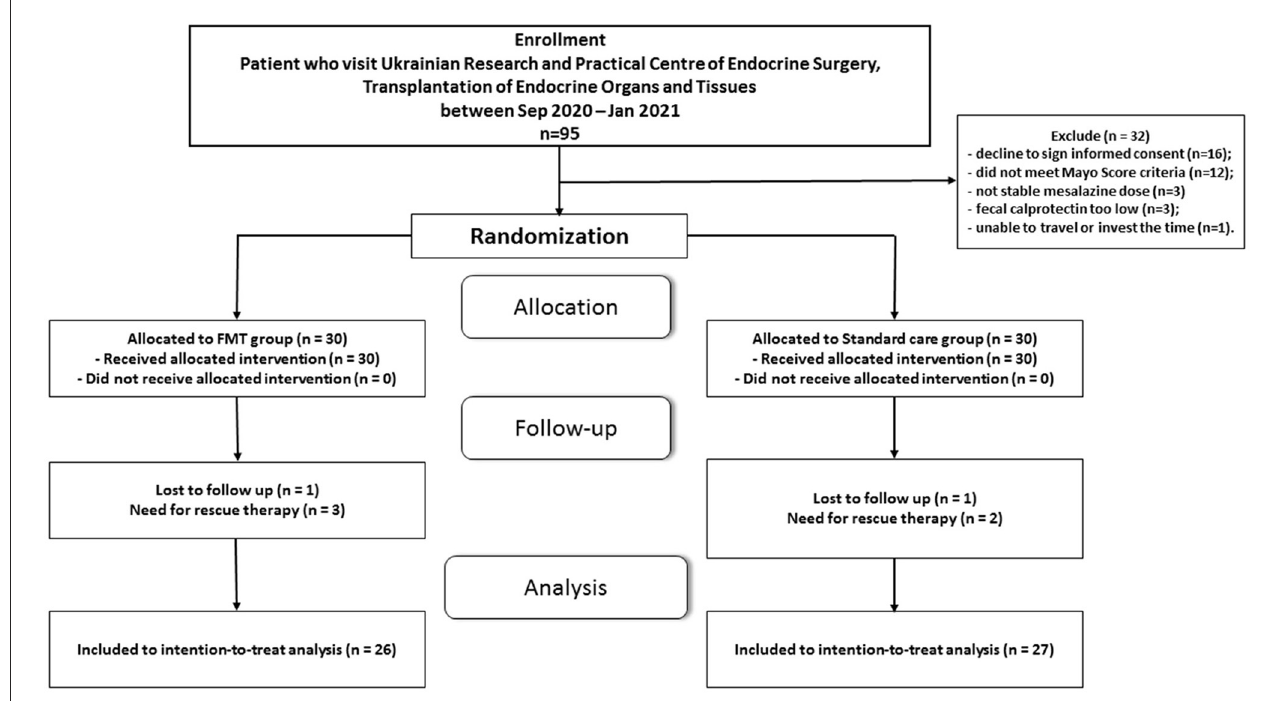
FIGURE1 Consolidated standards of reporting trials (CONSORT) flow chart-trial protocol.